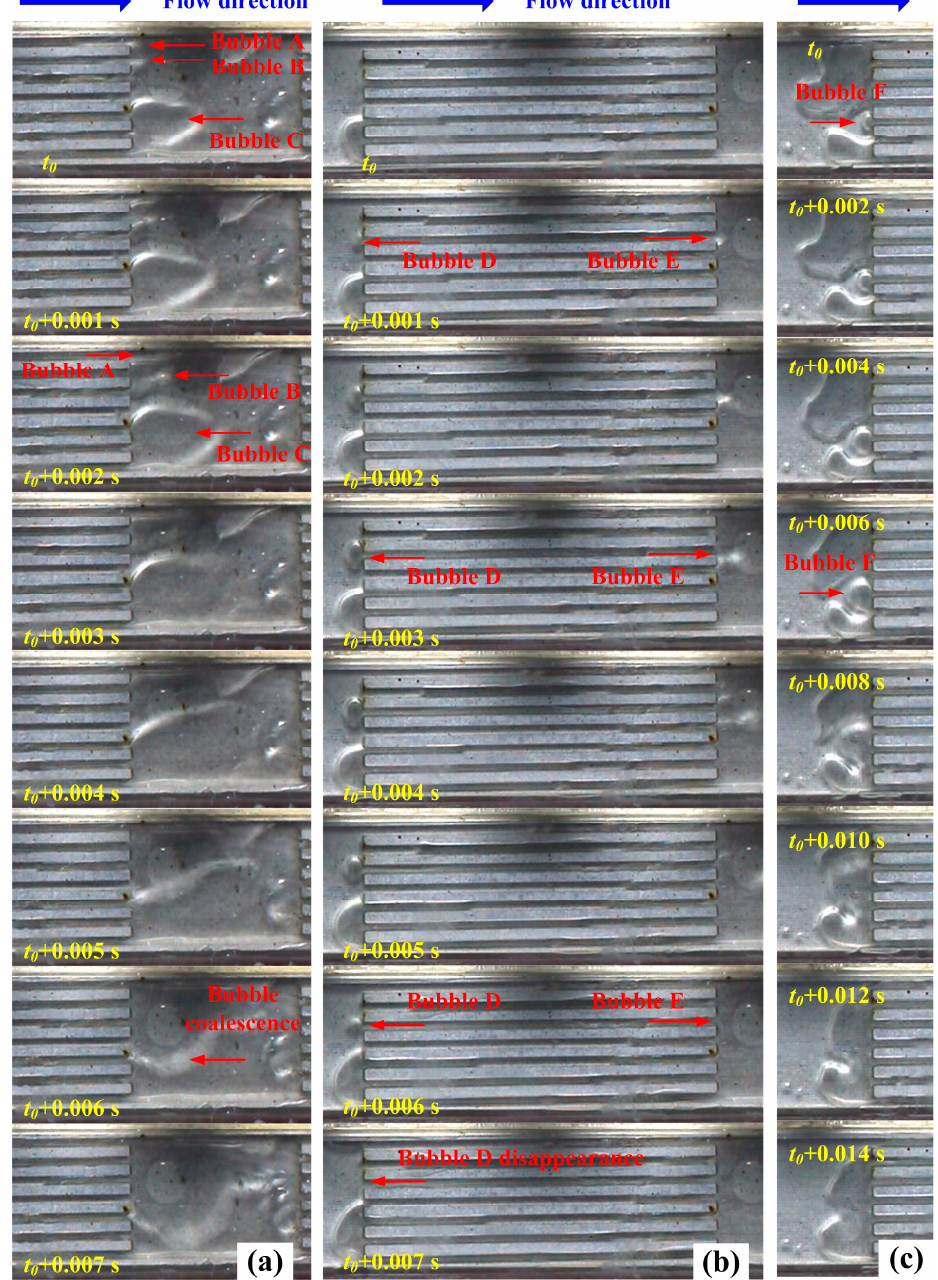
Figure 10. Effect of the interconnection area on the flow regime: ( a ) Bubble coalescence; ( b ) Bubble suction; ( c ) Bubble coalescence in inversed flow.